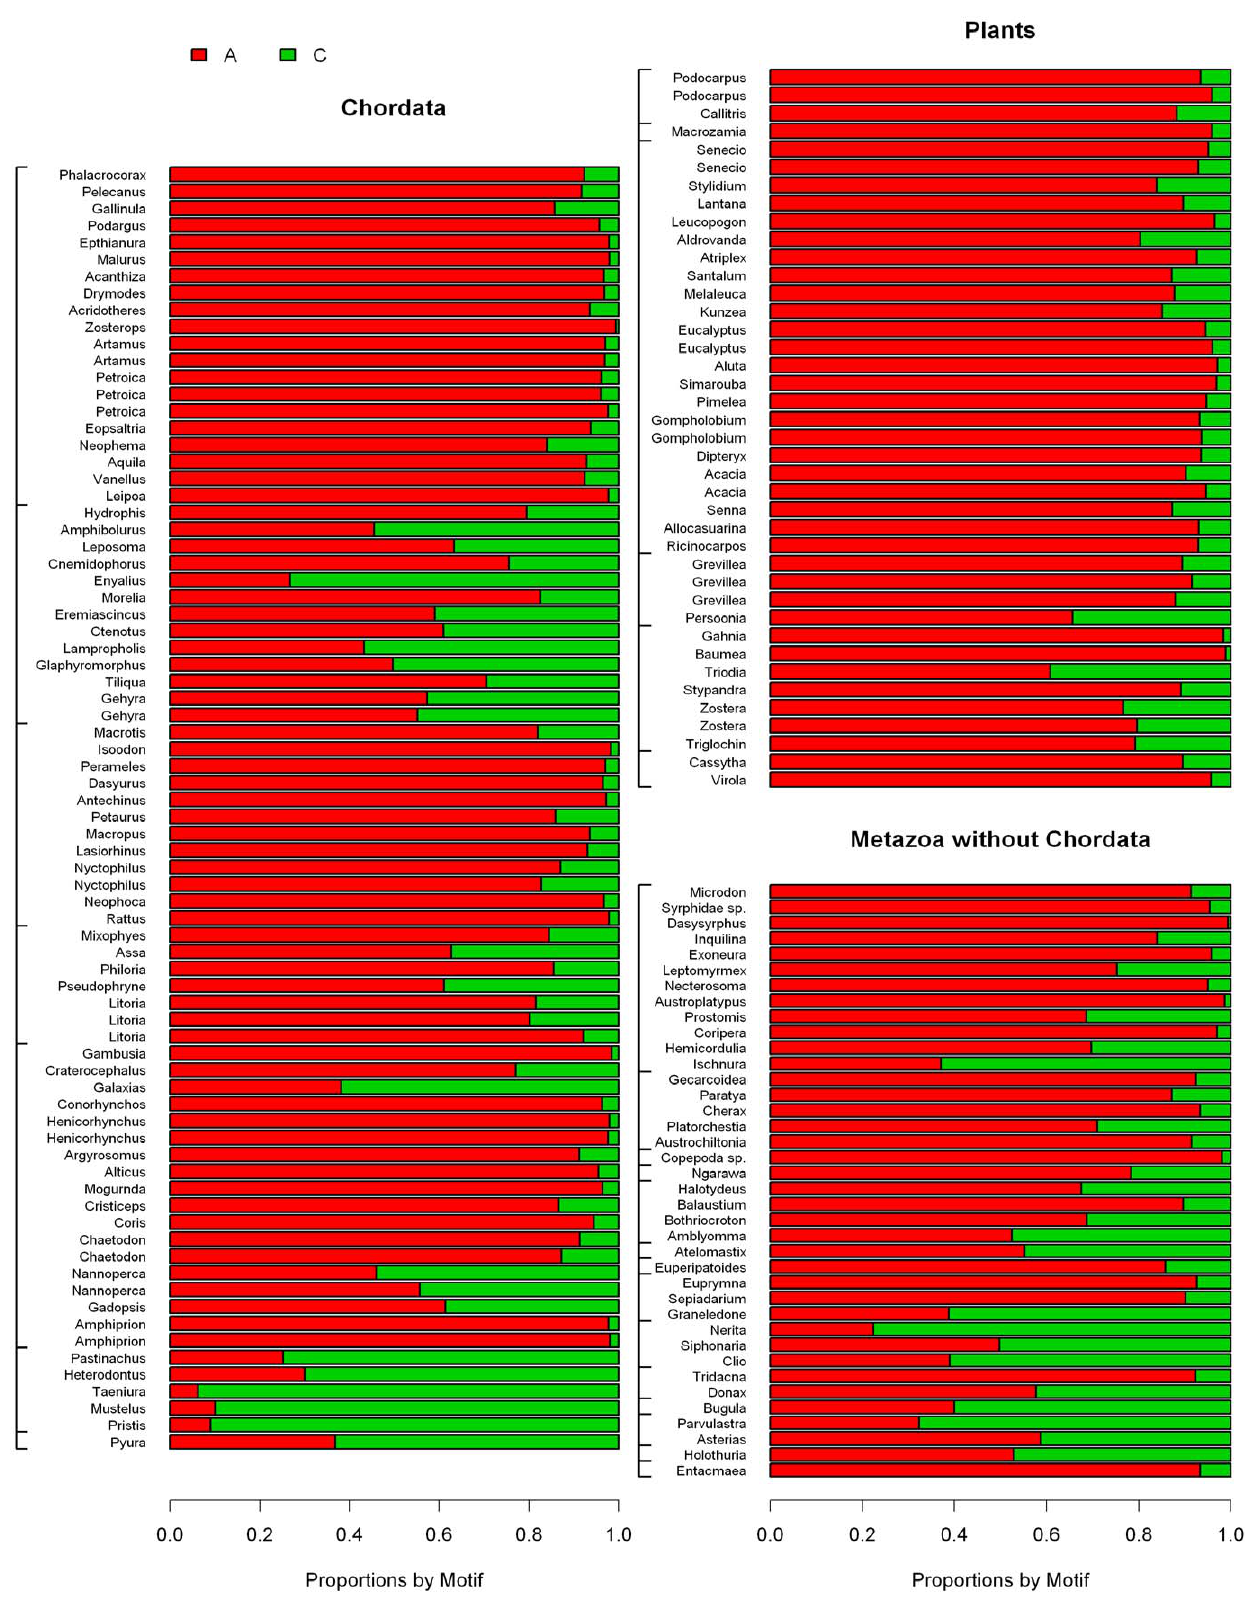
Figure 7. Proportion of A/T and C/G homopolymers for each species. (A) Chordates, (B) Animals without Chordata (C) Plants; species follow the same order as in Dataset S1 and in Figures 1 and 2.